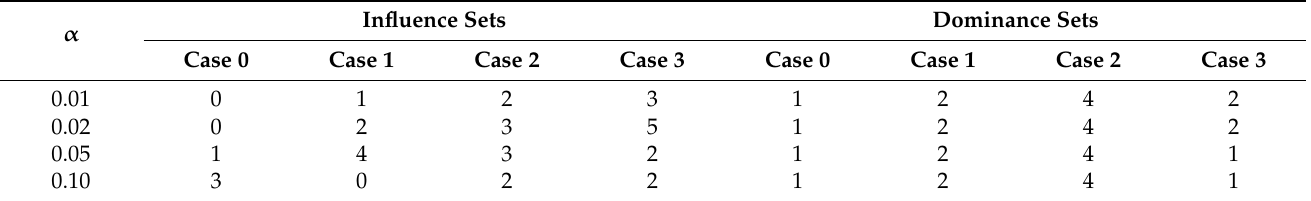
Table 18. The Numbers of One-Element Sets A S, j and A D, j j ∈ {1, 2, . . . , 14} for Considered Study Cases.